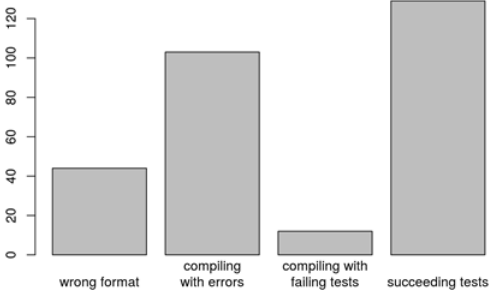
Fig. 3. Numbers of code submissions in the respective